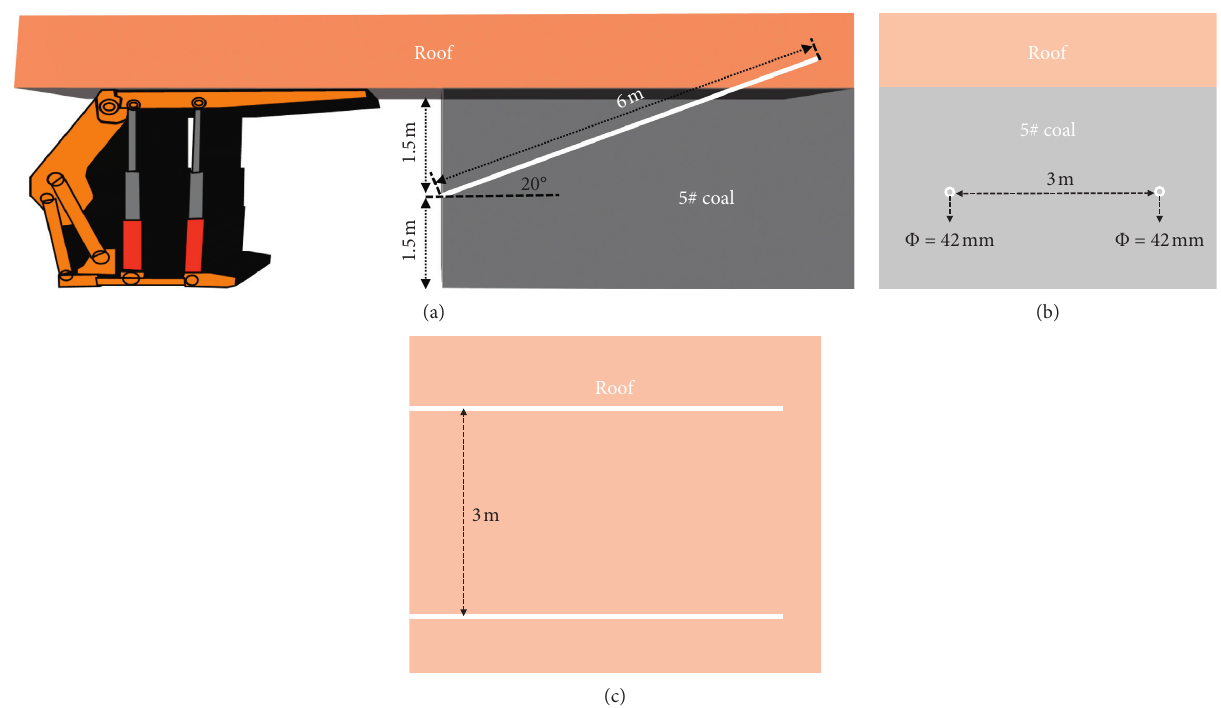
Figure 10: Grouting drilling design layout drawing. (a) Front view of drilling layout. (b) Side view of drilling arrangement. (c) Top view of drilling layout.